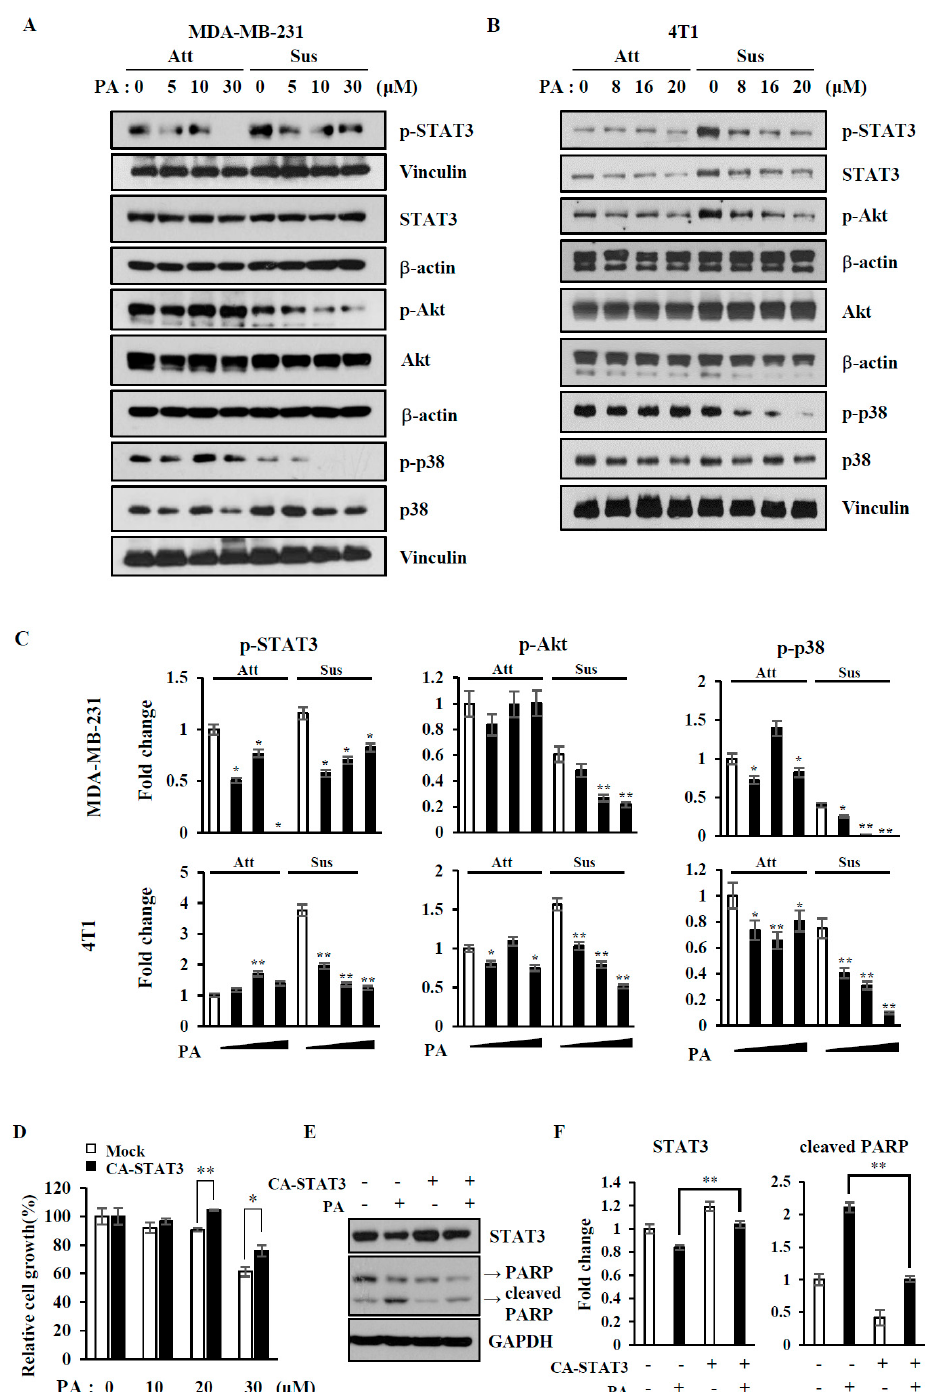
Figure 4. Effects of PA on the activity of STAT3, Akt, and p38 and anoikis resistance, as shown by constitutively active-STAT3 expression ( A , B ) MDA-MB-231 cells ( A ) and 4T1 cells ( B ) were treated with indicated concentrations (0–30 µM) of PA for 24 h, and cell lysates were subjected to immunoblotting analysis using the indicated antibodies. The levels of proteins were quantified by densitometry and normalized to a reference protein ( C ). ( D – F ) MDA-MB-231 cells were transfected with either vector only (Mock) or constitutively active STAT3 (CA-STAT3) for 24 h. Cells were then suspended and treated with the indicated concentrations of PA for 24 h, followed by MTS assay ( D ) or immunoblotting analysis using the indicated antibodies ( E ) and quantification of levels of proteins by densitometry ( F ). CA-STAT3 and / or PA treatment were marked with “ + ”. Similar results were observed in three independent experiments. Error bars represent standard deviations of the mean of three measurements (* p < 0.05, ** p <